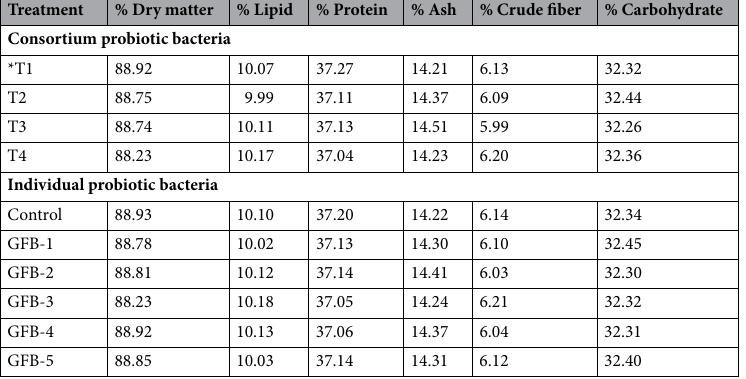
Table 5. Analysis of proximate composition of control feeds, consortium and individual of the graded level of probiotic treated feeds (dry matter basis) for the rearing of B. gonionotus. *Denotes